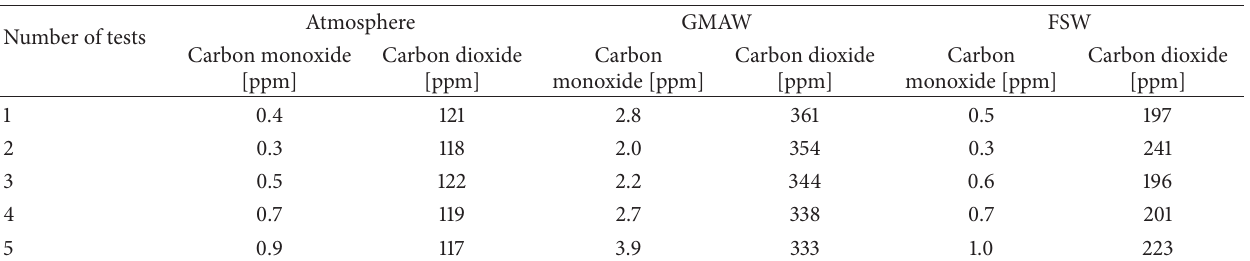
Figure 12: SEM image and EDX analysis of the NZ of Al-Al FSW joint performed at a rotational speed of 2720 rpm. Table 2: The amounts of the released gases in the welding area prior to and after